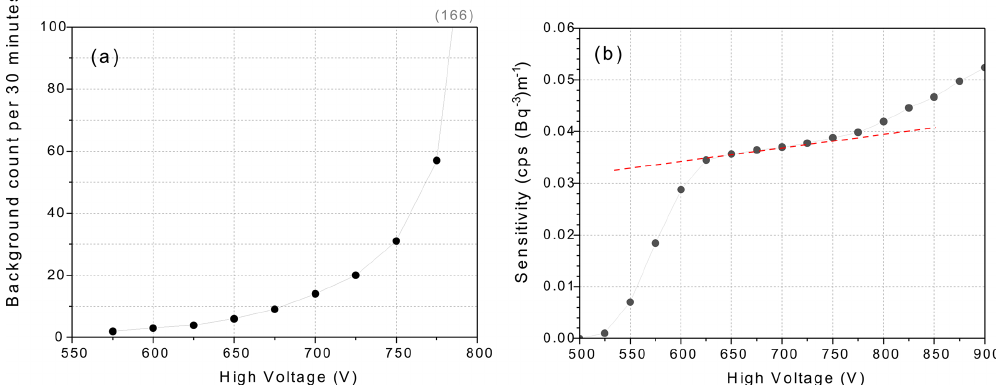
Figure 3. Example (a) instrumental background, and (b) sensitivity response, as a function of HV supplied to the counting assembly at a constant radon concentration (in this case 190Bqm − 3 ).